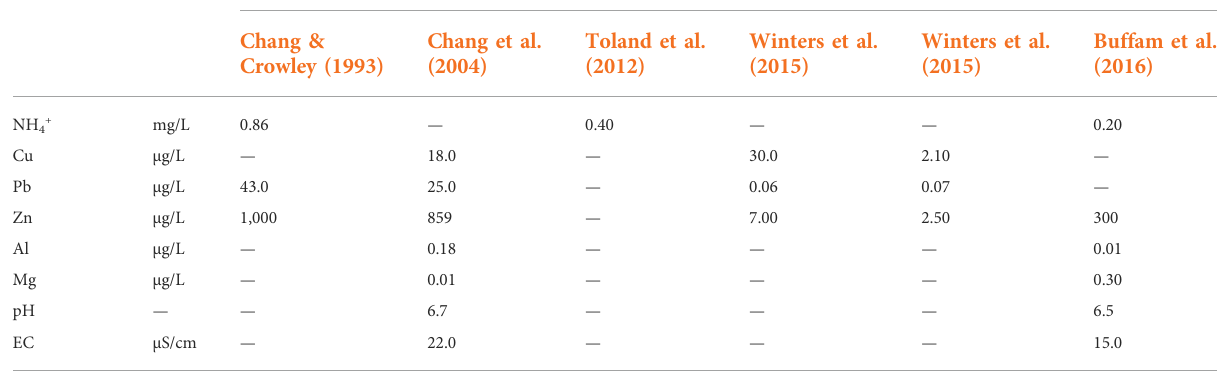
TABLE 6 Values of different parameters in asphalt shingle roof